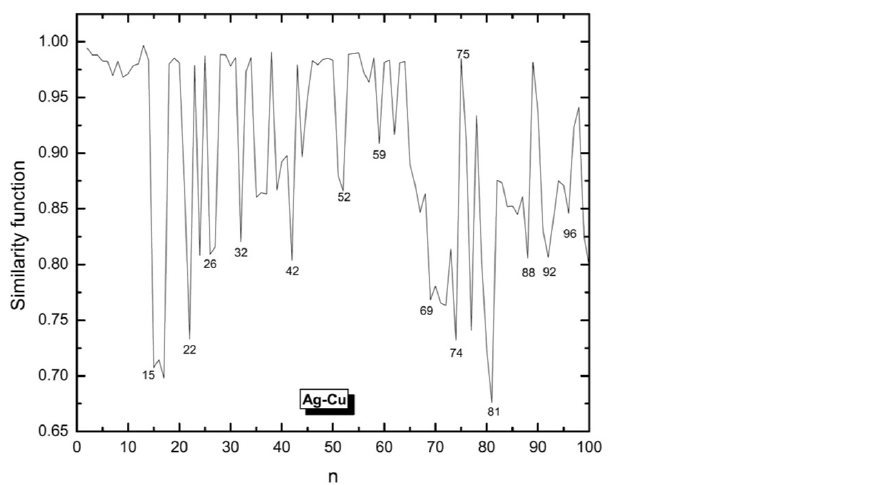
Figure 3. Similarity function for the comparison of silver clusters with copper clusters. Structures of both systems have been defined by the same EAM potential model but global optimization of Ag clusters have been done by BH and those for Cu are the results of Aufbau/Abbau optimizations. The similarity function is based on the radial distances.